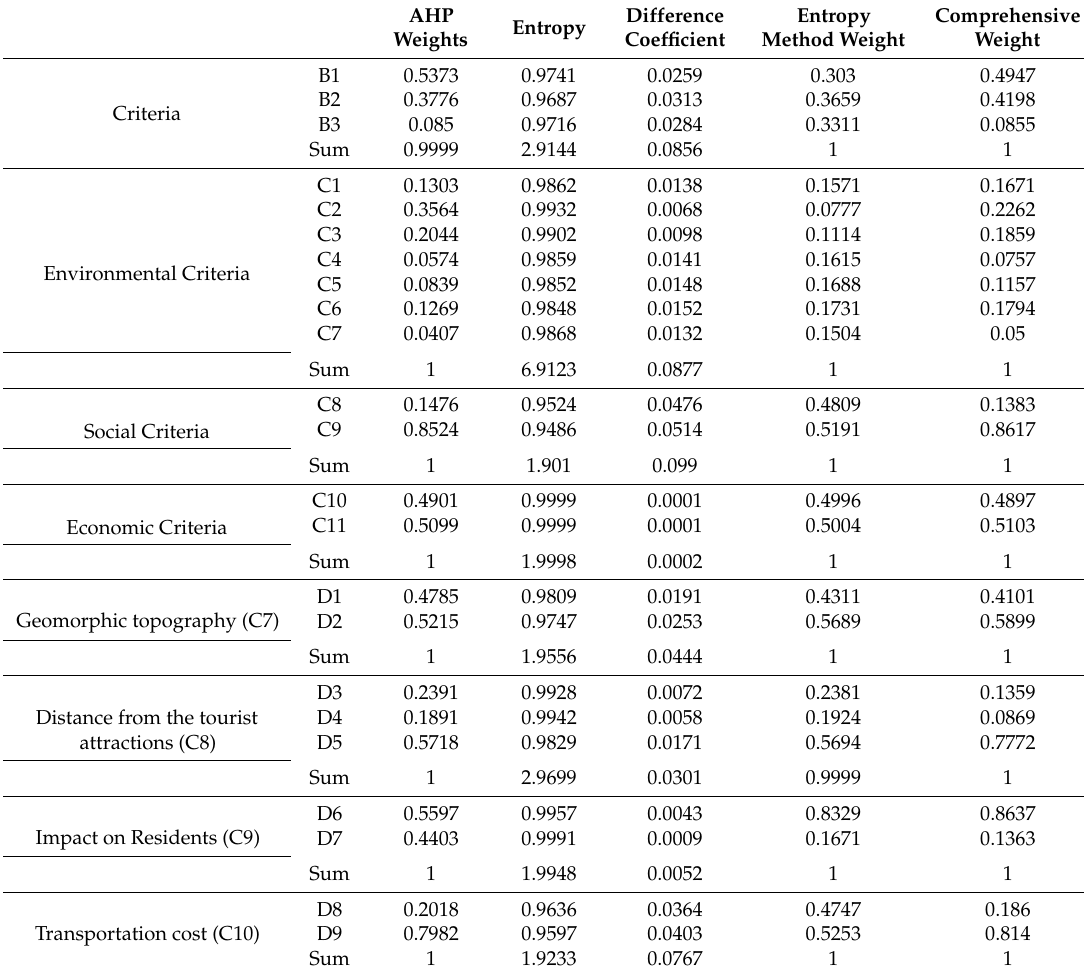
Table 3. AHP-entropy analysis results of all influencing factors.